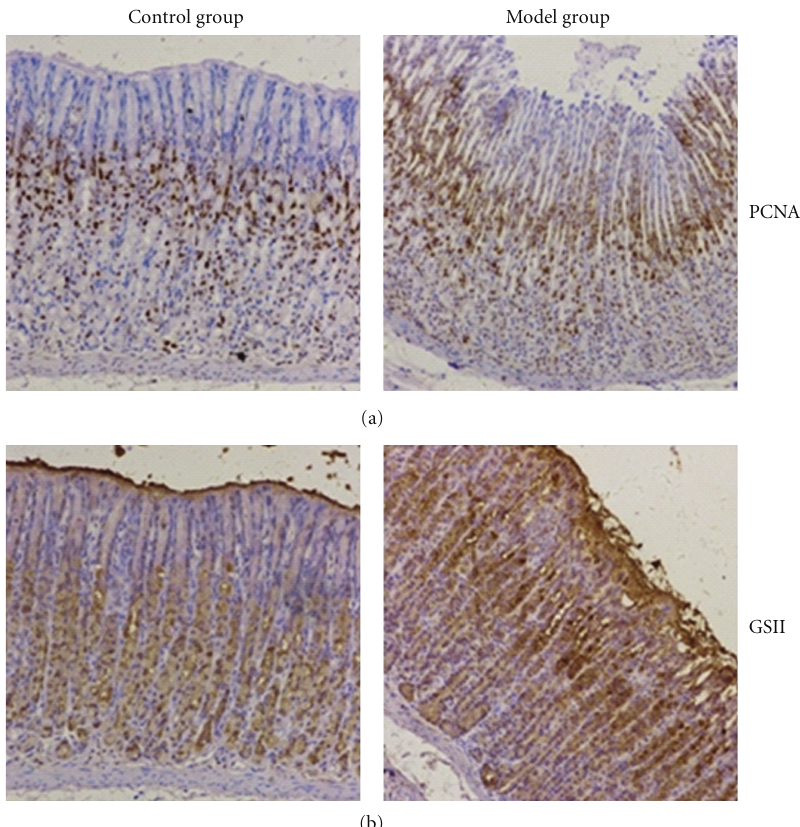
Figure 2: Immunohistochemistry stains of PCNA and GSII in gastric glands. (a) Positive stain of PCNA in cellular nucleus, which are mainly localized in deep layer of gastric glands in normal rats (left diagram), while extended to whole glands in atrophic gastritis (right diagram). (b) GSII was moderately positive stained in the neck and deep layer of gastric glands in normal rats (left diagram). It showed of strong stain in the neck and upper areas in the gastric glands in rats with atrophic gastritis (right diagram). Control group: normal control rats; Model group: atrophic gastritis rats. ∗ P < 0 . 05, ∗∗ P < 0 .